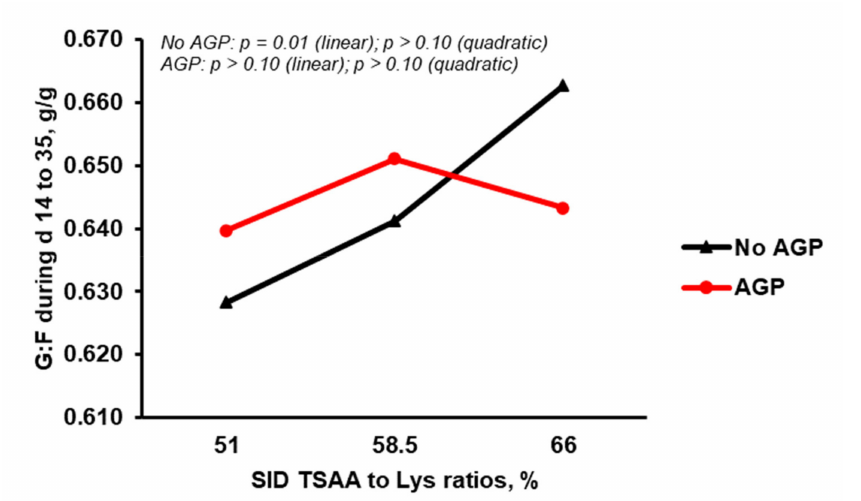
Figure 2. Effect of antibiotic growth promoter (AGP) and standardized ileal digestible (SID) total sulfur amino acids to lysine ratio (TSAA:Lys) on gain to feed ratio of nursery pigs from d 14 to 35 (orthogonal contrast